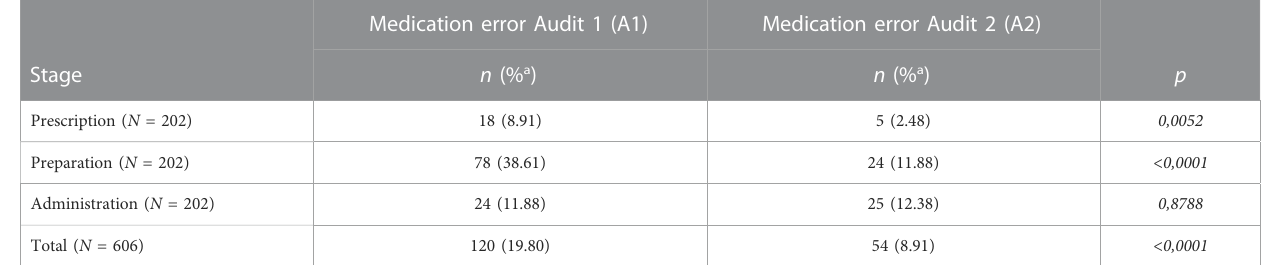
TABLE 2 Evolution of the number and rate of medication errors between the two audits by stages of the drug management of MEs between two audits by stages of